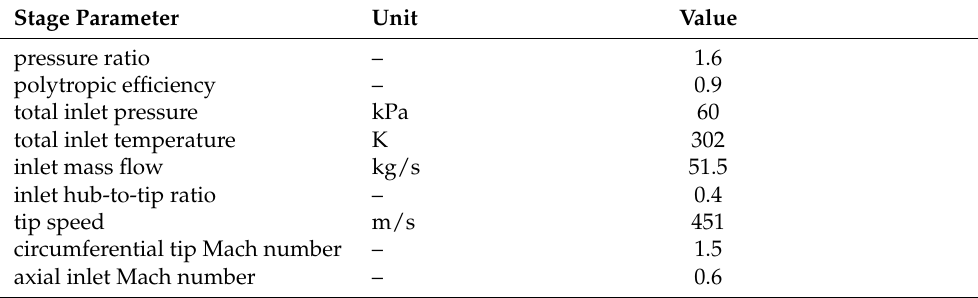
Table 1. Characteristics of the reference